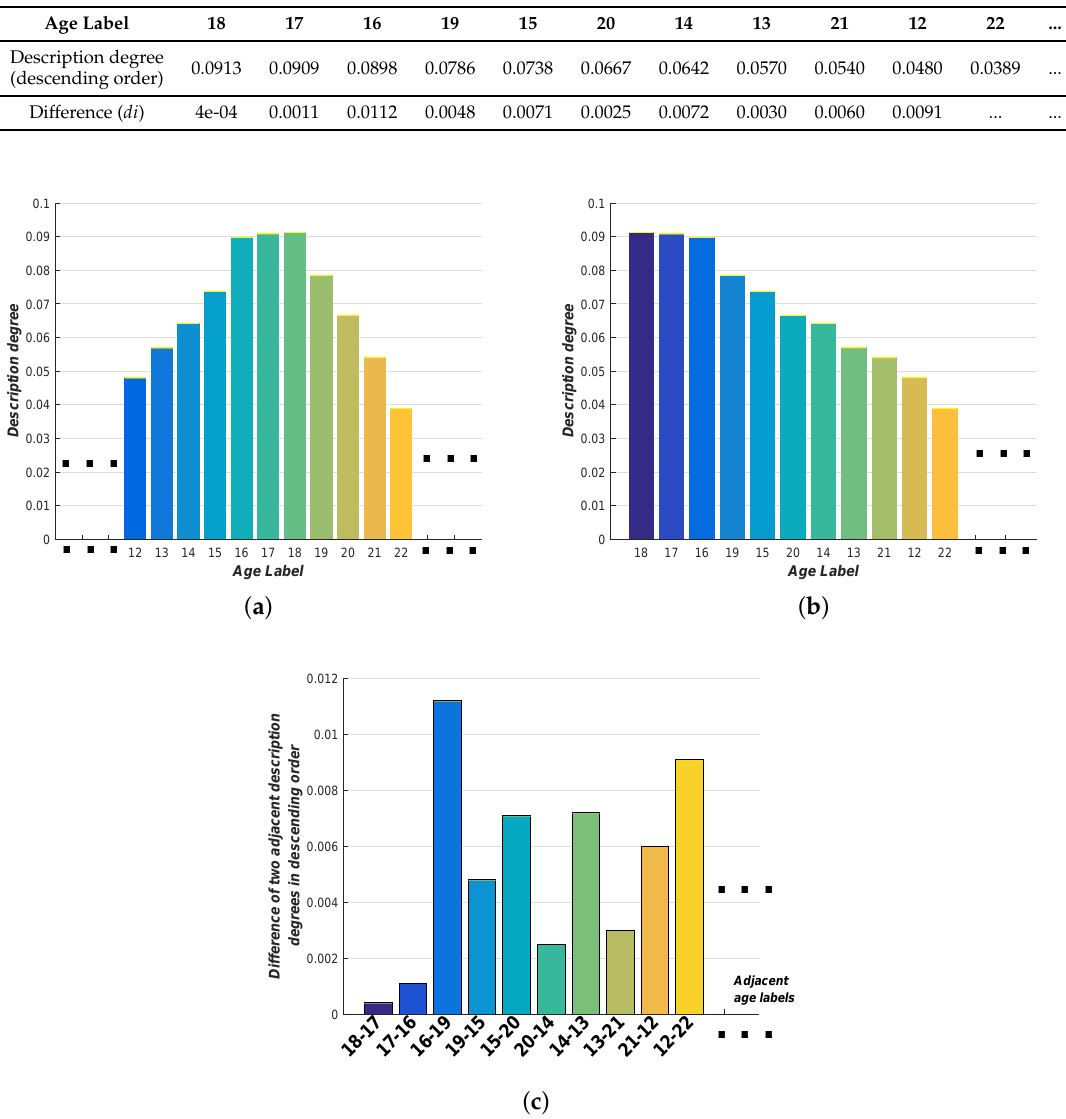
Table 2. Based on Table 1, the age label distribution with descending-order description degrees and successive differences di .